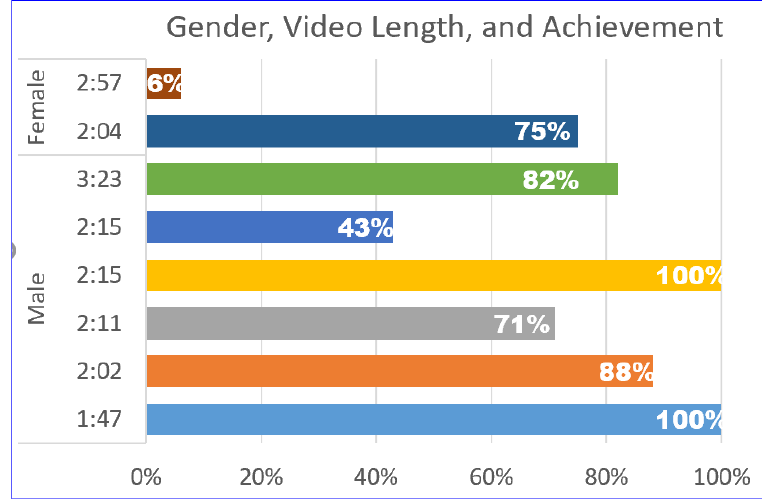
Fig. 3. Length of video by author’s